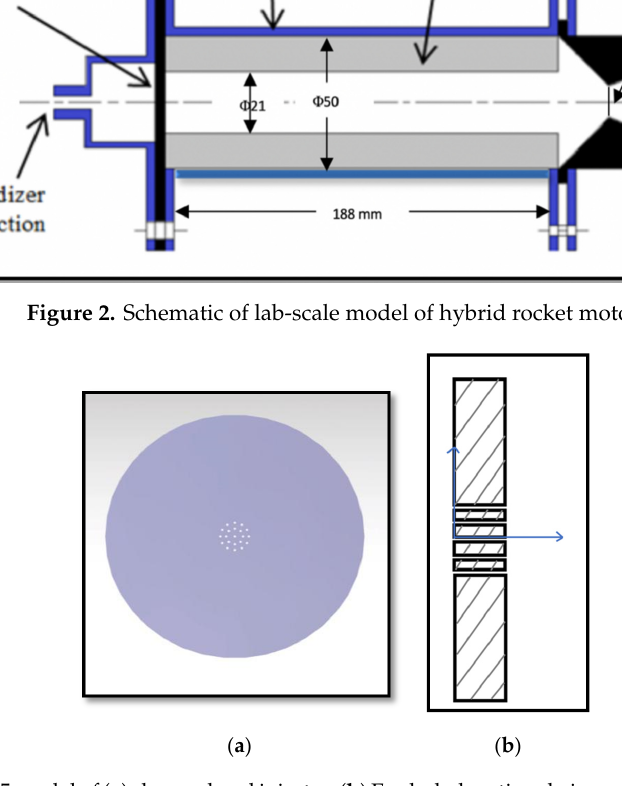
Figure 2. Schematic of lab-scale model of hybrid rocket motor.